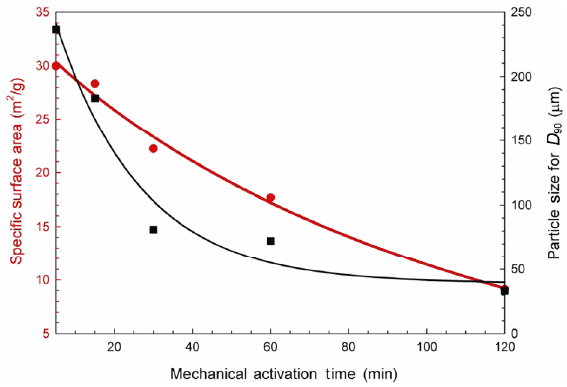
Fig. 5 Specific surface area and particle size for D 90 graph of the mechanically activated powder mixture for different milling time.